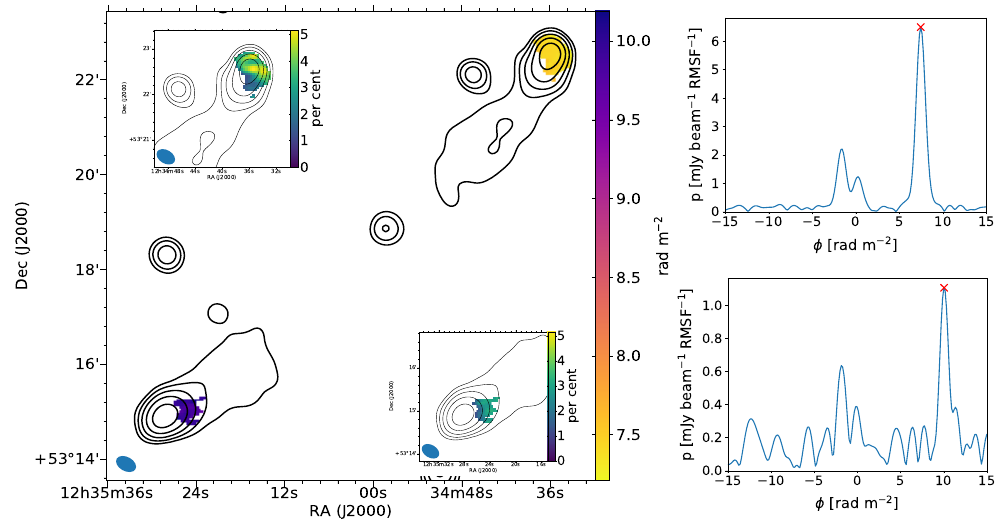
Figure 3. Faraday rotation and degree of polarisation image for ILT J123459.82 + 531851.0 (described in Section 3.3), adapted from Reference [30]. ( Main image ) Total intensity contours at 25 (cid:48)(cid:48) with the colour scale showing the Faraday rotation measure (RM) of regions detected in polarisation; ( insets ) zoom-in on the NW and SE lobes, with the degree of polarisation shown with the colour scale; ( top right ) Faraday dispersion function (FDF) for the peak polarised intensity in the NW lobe. The red cross marks the peak of the source-related polarised emission. The other peaks are either noise peaks or related to instrumental polarisation; ( bottom right ) FDF for the brightest polarised intensity pixel of the SE